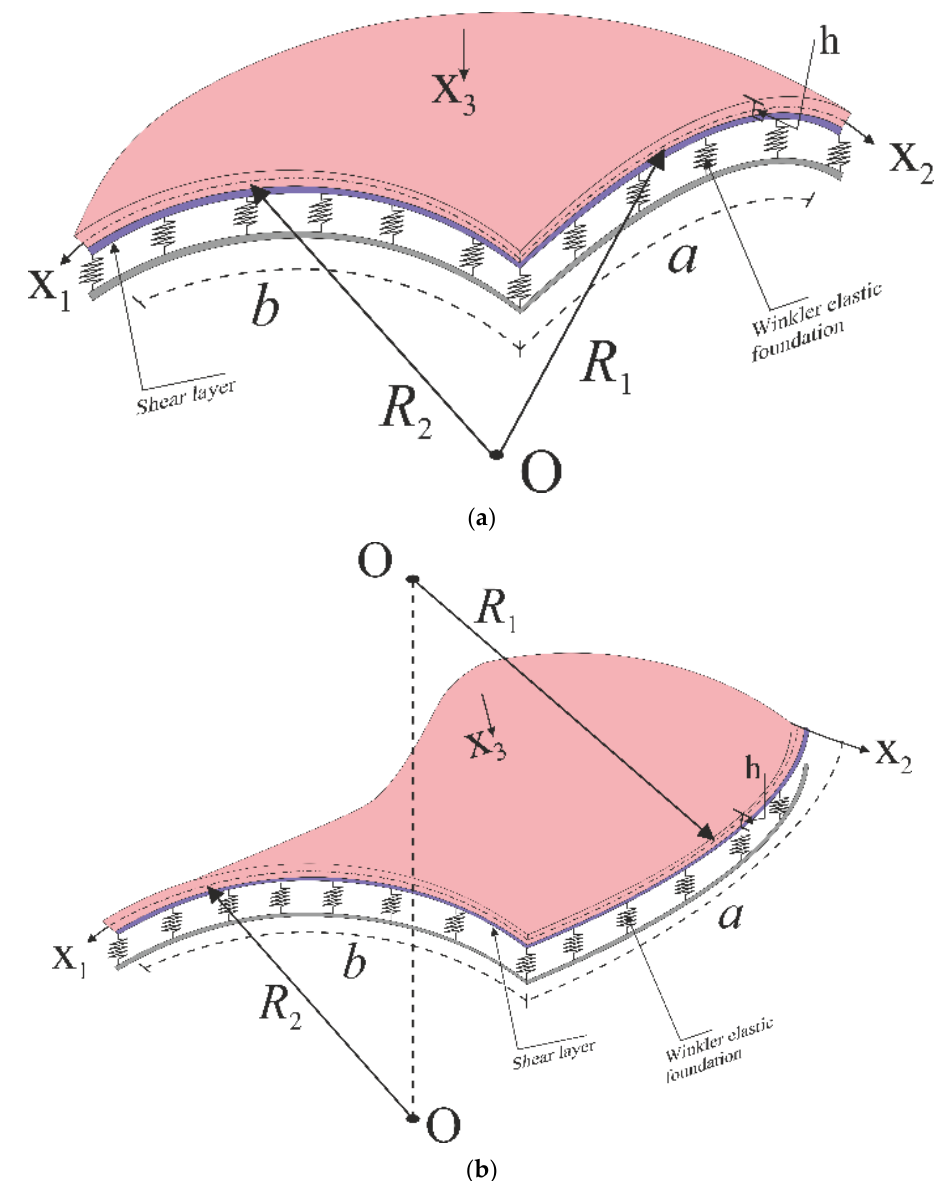
Figure 1. ( a ) Spherical and ( b ) hypar shallow shells reinforced with CNTs, resting on elastic foundations.